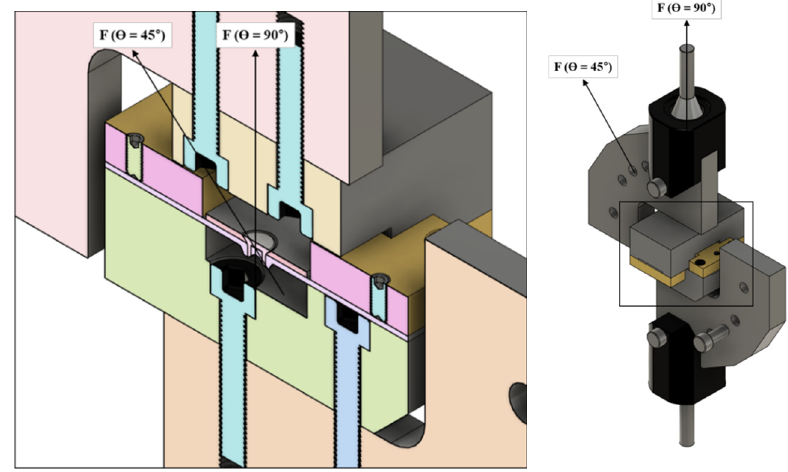
Figure 3. Loading angle fixture for the cross-shaped SPR joint specimen.